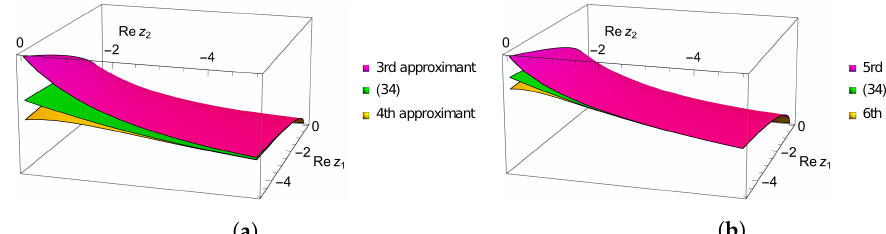
Figure 2. The plots of values of the n th approximants of (33).